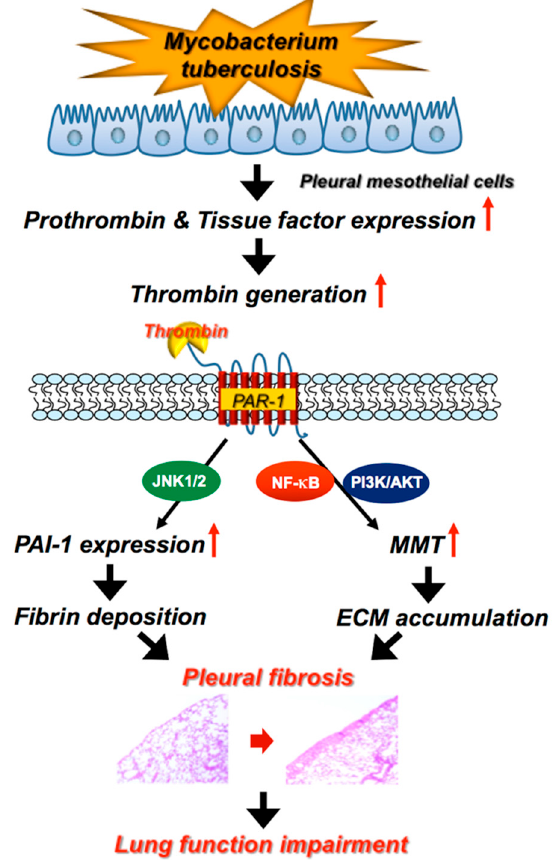
Figure 7. Schematic diagram of the activated signalings of PAI-1 expression and MMT in human pleural mesothelial cells upon Mycobacterium tuberculosis infection and thrombin stimulation. Mycobacterium tuberculosis triggers tissue factor and prothrombin expression to generate thrombin that activates PAR-1 to elicit PAI-1 overexpression and fibrin deposition and to induce MMT and ECM accumulation possibly via JNK and PI3K/AKT and NF- κ B signaling pathways, respectively, and ultimately gives rise to pleural fibrosis in TBPE (see text for further explanation). PAI-1, plasminogen activator inhibitor-1; MMT, mesothelial–mesenchymal transition; PAR-1, protease-activated receptor-1; JNK, c-Jun N -terminal kinases; NF- κ B, nuclear factor- κ B; PI3K, phosphatidylinositol 3-kinases; AKT, protein kinase B; ECM, extracellular matrix; TBPE, tuberculous pleural effusion.